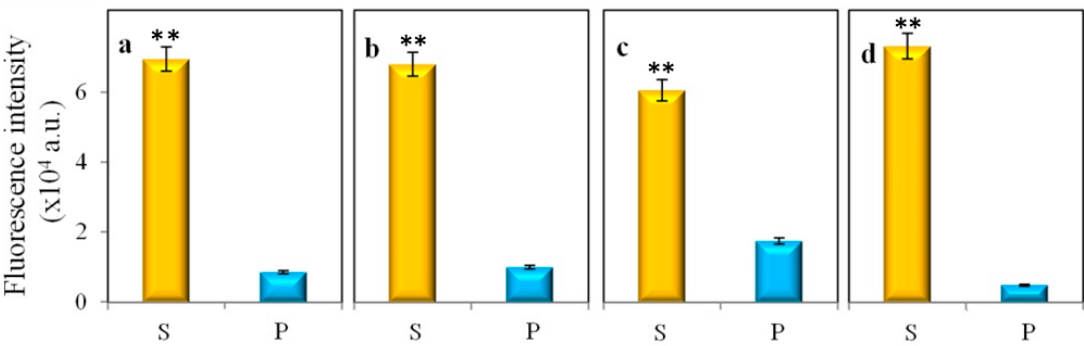
Figure 4. Comparison of fluorescence changes after cell lysis between different variants: ( a ) sonication; ( b ) lysis at 90 °C; ( c ) homogenization using a mortar and pestle and liquid nitrogen; and ( d ) denaturation at 80 °C + an ultrasound needle. The vertical axis represents the fluorescent intensity at the emission maximum at a wavelength of 536 nm. Four hundred fifty nanometers was used here as the excitation wavelength. The supernatant and pellet are designated as S and P, respectively. Data represent the mean ±SD, n = 5. Data represent the mean ±SD of the mean of three individual experiments. * p < 0.01 or ** p < 0.001.